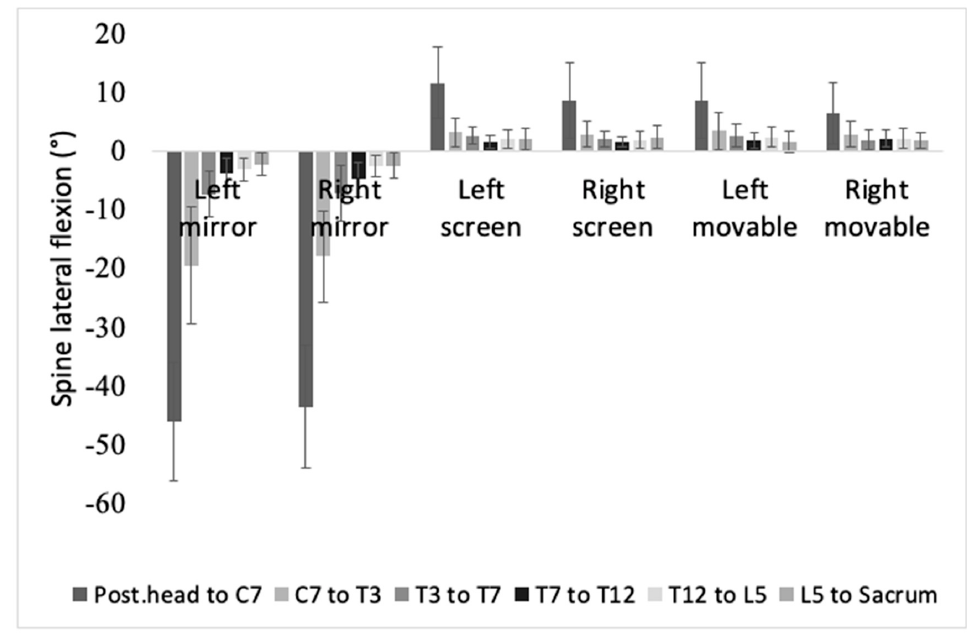
Figure 5. This bar chart shows mean value of spine lateral flexion of each segment in each condition.